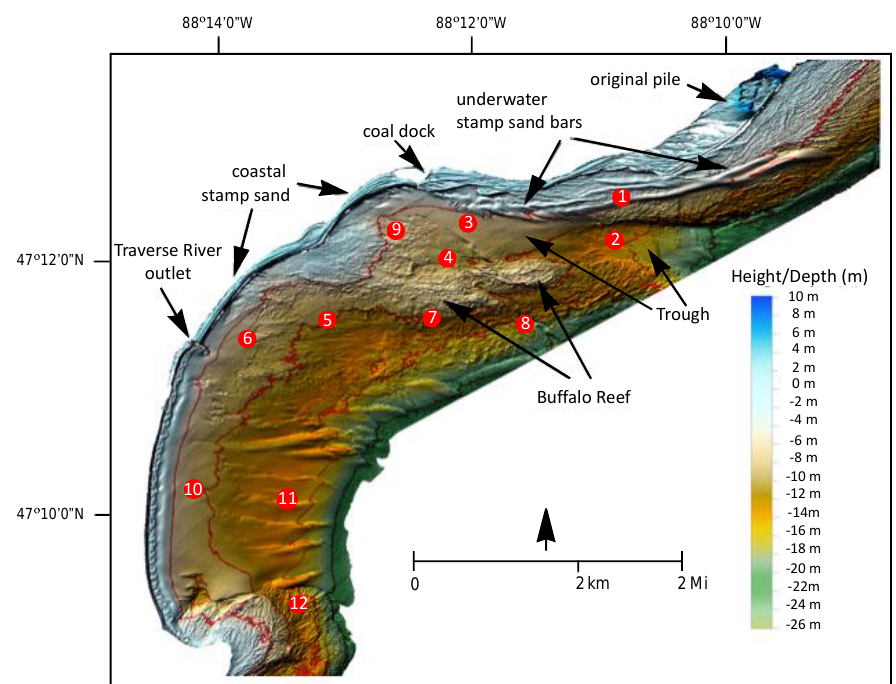
Figure 6. Comparisons of CCIW RoxAnn sonar bathymetry ( top , after [22]), color-coded by 4 m depths (bottom scale) and NOAA 2010 LiDAR bathymetry of Grand Traverse Bay ( bottom ). The LiDAR DEM is color-coded by elevation and water depths at 2 m intervals (lower right scale). Red horizontal contour lines are at 5m depth intervals. Hill shade techniques (northern illumination) create the 3-D-like image. Site numbers are discussed in the text.